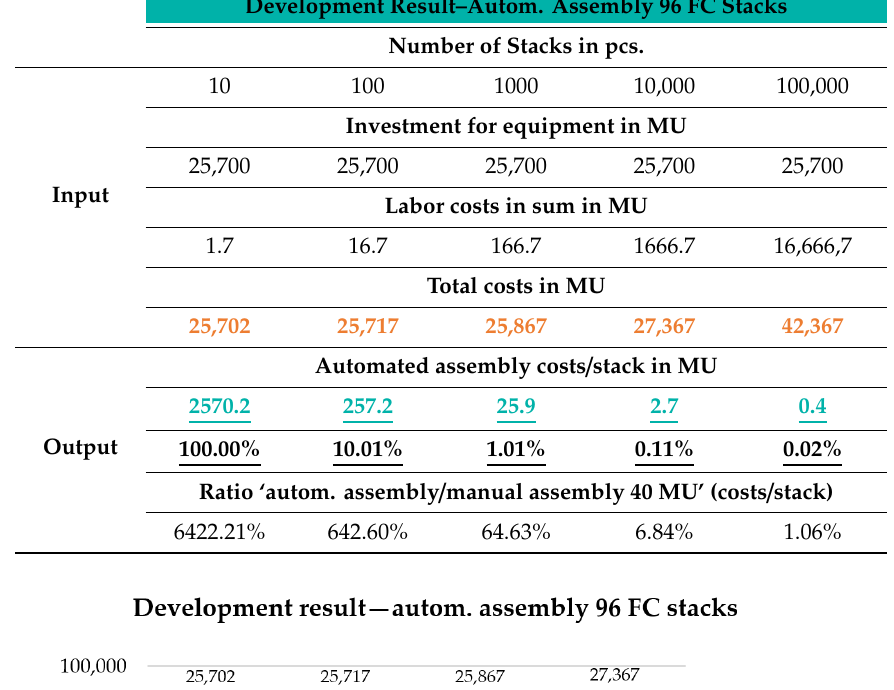
Table 3. Developed MMM—automated assembly of the “modular system seven-layer MEA”—production time 10 min / stack with one operator.